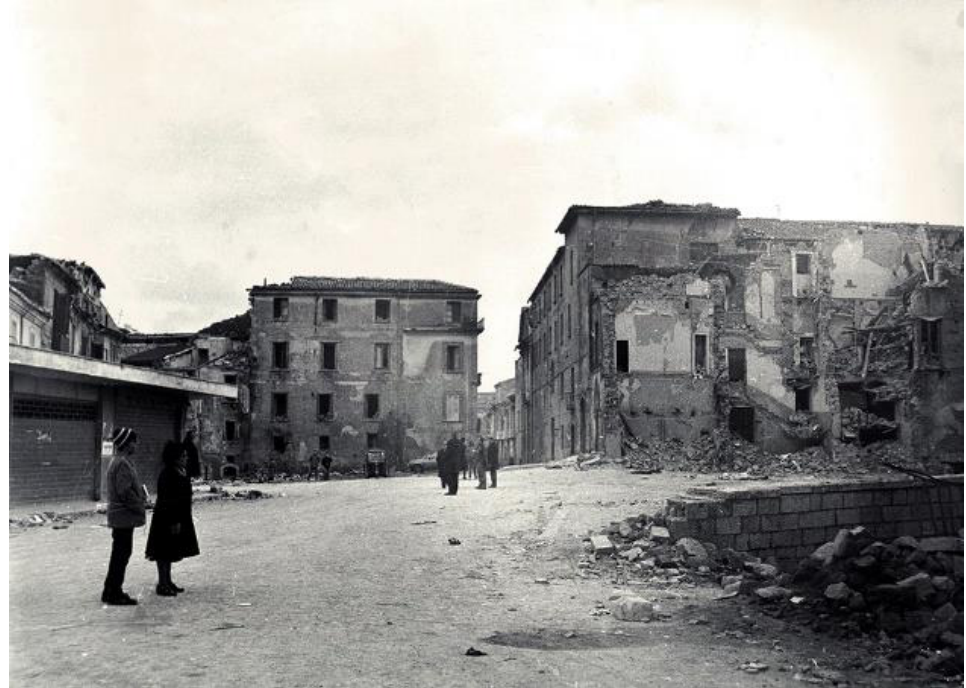
Figure 118. Avellino: “Piazza del popolo” after the 1980 earthquake (courtesy of F. Capossela).